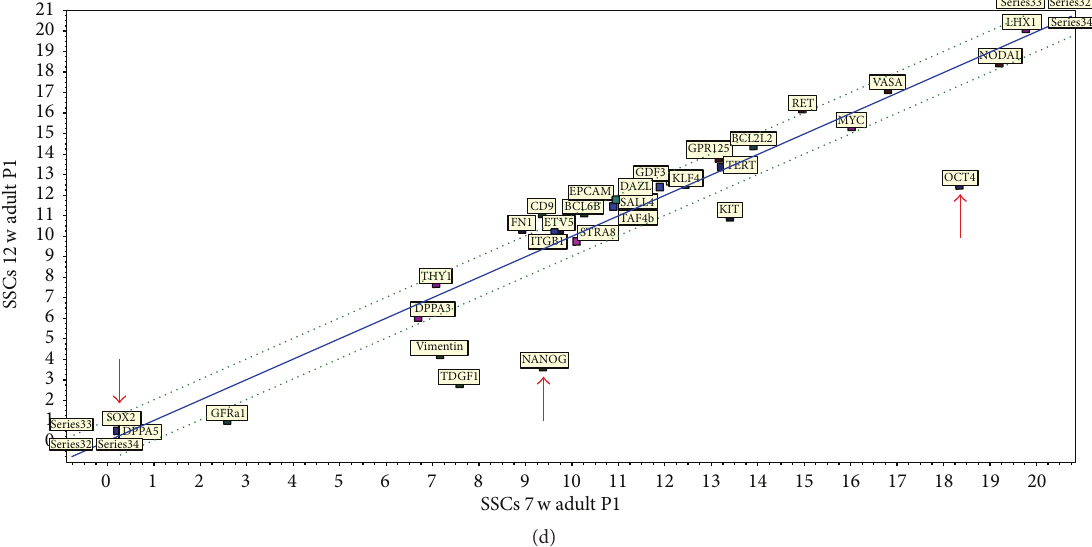
Figure 4: (a) Heat map and (b–d) correlation analyses reveal expression levels of core pluripotency genes Oct4, Nanog, and Sox2 decrease in SSCs with age of the animal. A decline in Oct4, Nanog, and Sox2 expression is clearly observable after 7 weeks of age and becomes even more evident after 12 weeks of age. Arrows in (b–d) mark the localization of Oct4, Nanog, and Sox2 in the correlations.